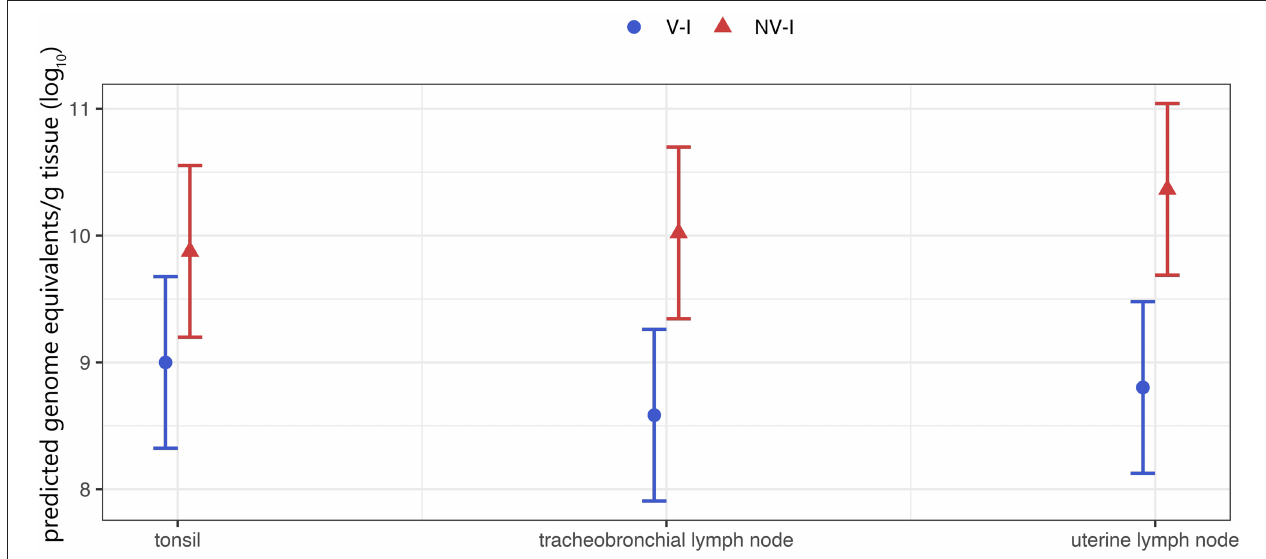
FIGURE 8 | Tissue viral load of the gilts (tonsil, tracheobronchial and uterine lymph node) per treatment group. The porcine reproductive and respiratory syndrome virus (PRRSV) RNA was below the detection limit of PRRSV-1 AUT15-33-specific RT-qPCR in all tissue samples from the control animals (NV–NI and V–NI gilts). Therefore, only the two infected groups are shown. V–I, vaccinated and infected gilts, blue color; NV–I, non-vaccinated and infected gilts, red color. The values in the Y-axis represent viral load as determined by RT-qPCR. The data points indicate the estimated marginal means of each group, and the error bars illustrate the respective confidence interval (confidence level of